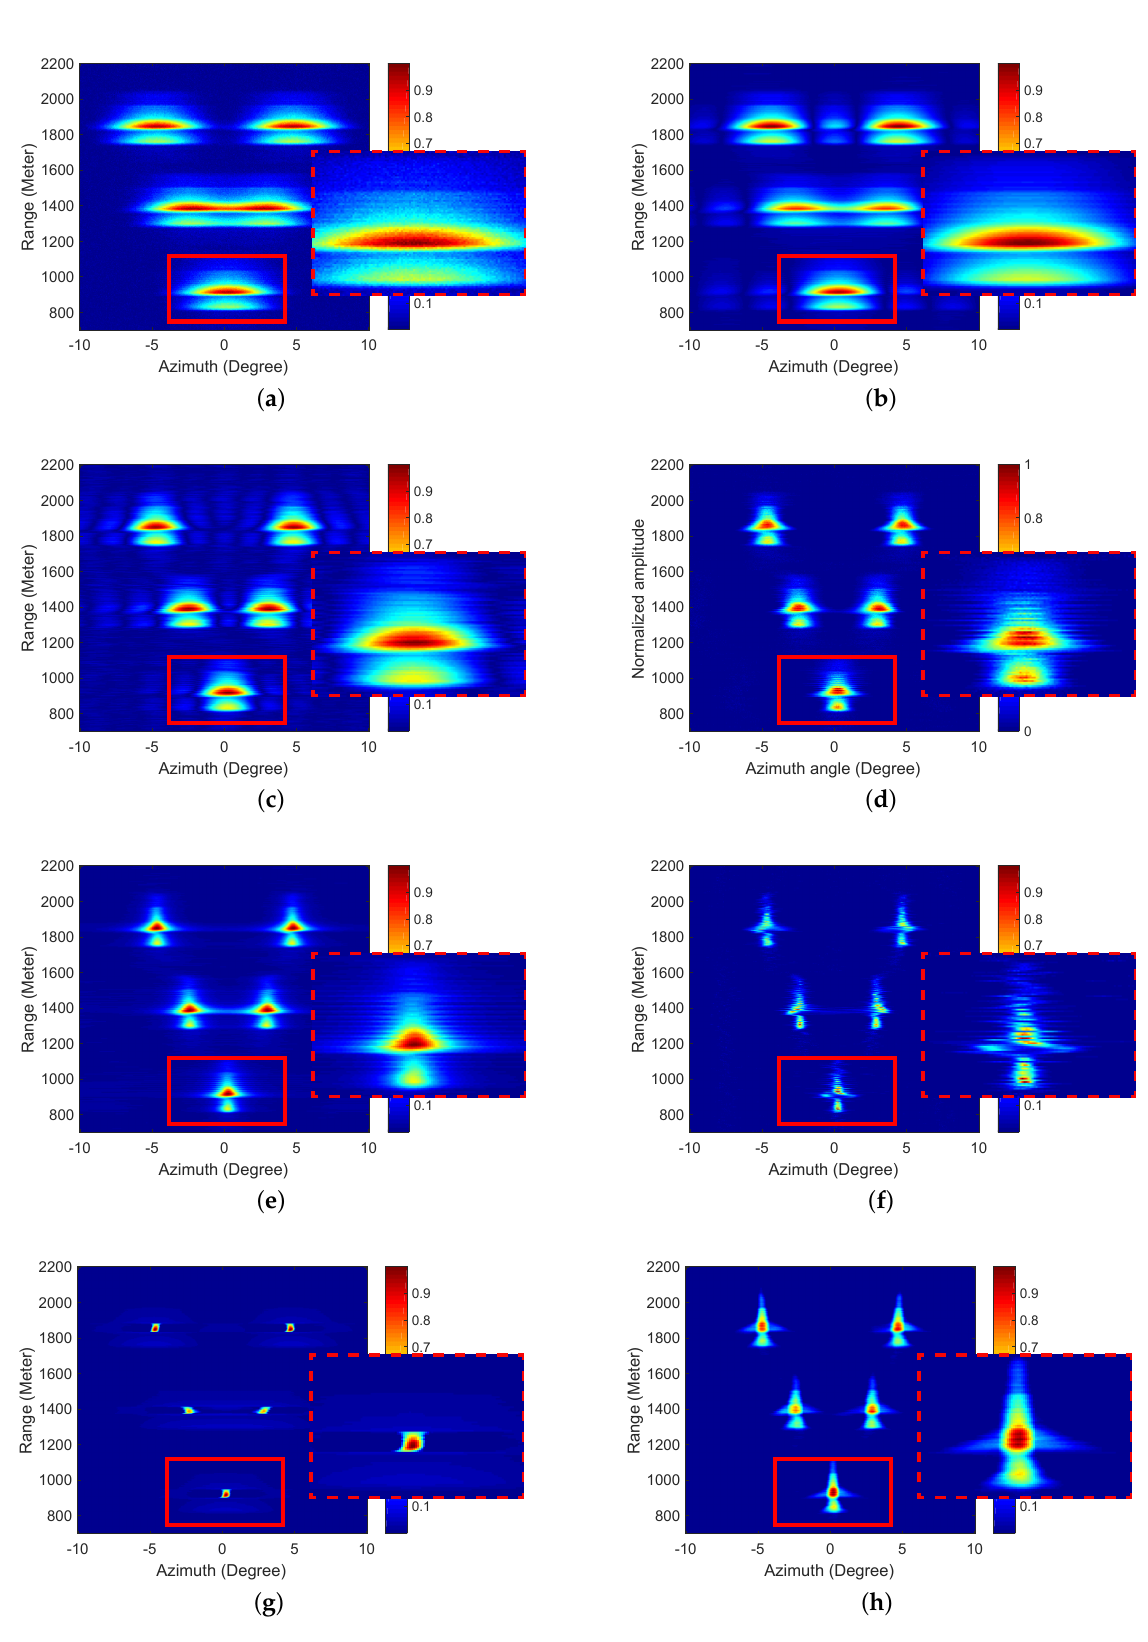
Figure 5. Area targets simulation results with the SNR of 20 dB. ( a ) Real-aperture echo. ( b ) Result processed by TSVDM. ( c ) Result processed by FTVM. ( d ) Result processed by MLE. ( e ) Result processed by IAA. ( f ) Result processed by MAPE. ( g ) Result processed by SSM. ( h ) Result processed by